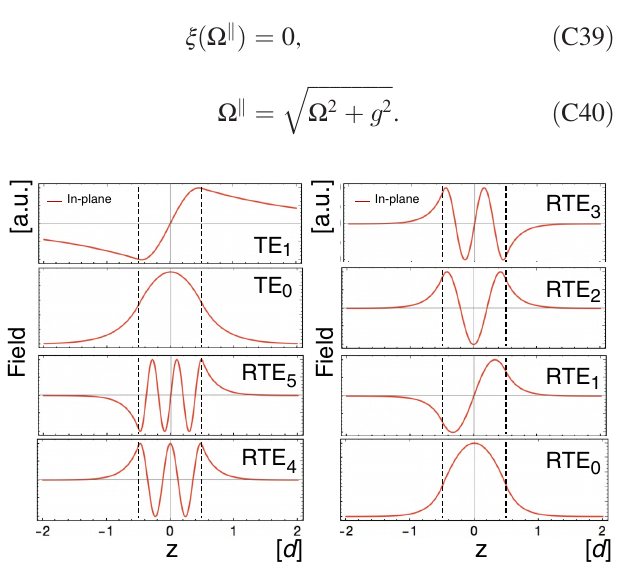
FIG. 10. Spatial profiles of the TE modes in the cavity configuration. The black dashed vertical lines indicate the metal-insulator interfaces. The mode functions f k η of all the TE modes have only the in-plane components, whose spatial profiles are shown by the red solid curve (corresponding to the y component of the electric field). The parameters are the same as in Fig. 6. We use q ¼ 0 . 1 Ω =c for the sake of concreteness, while the spatial profiles of the TE modes are qualitatively insensitive to a specific choice of the in-plane momentum q